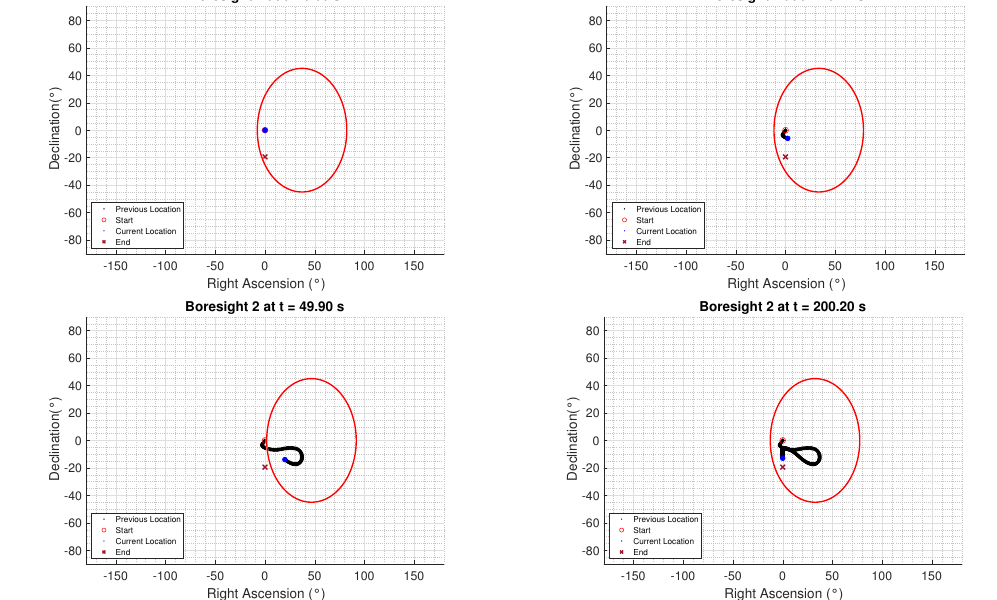
Figure 21. Boresight 2 trajectory at different times of the simulation, γ = 1.5 is